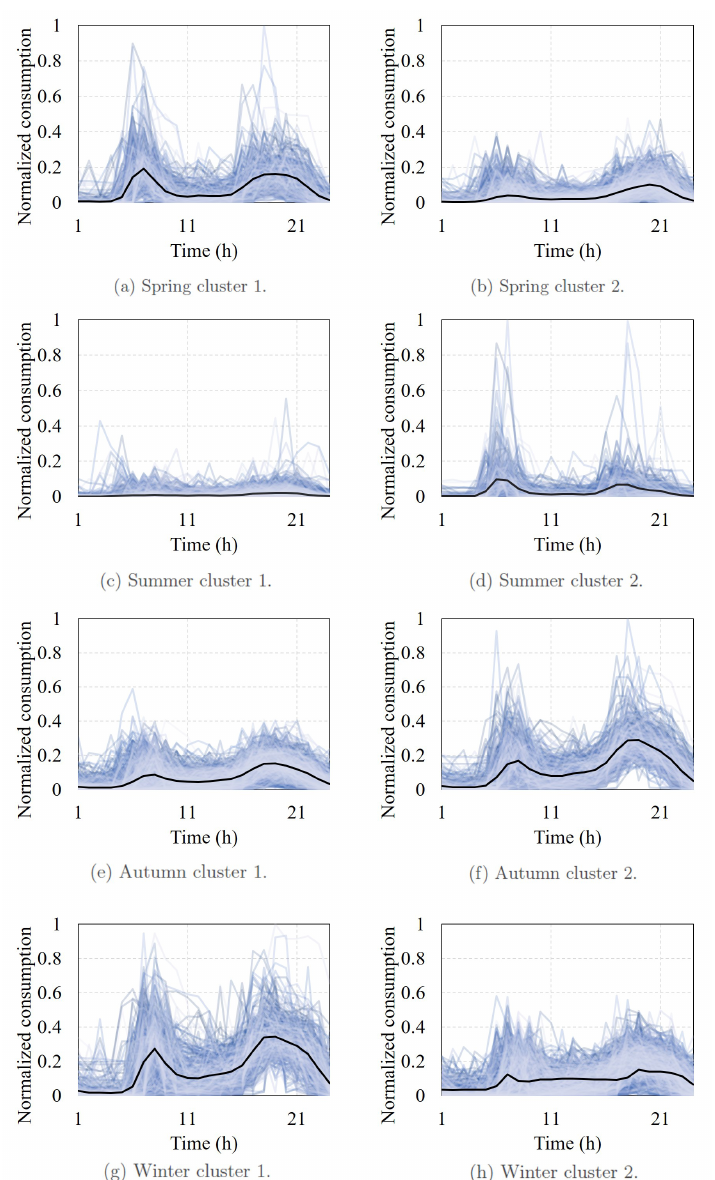
Figure A1. Seasonal profiles for two clusters using the KM algorithm: ( a ) Spring cluster 1; ( b ) Spring cluster 2; ( c ) Summer cluster 1; ( d ) Summer cluster 2; ( e ) Autumn cluster 1; ( f ) Autumn cluster 2; ( g ) Winter cluster 1; and ( h ) Winter cluster